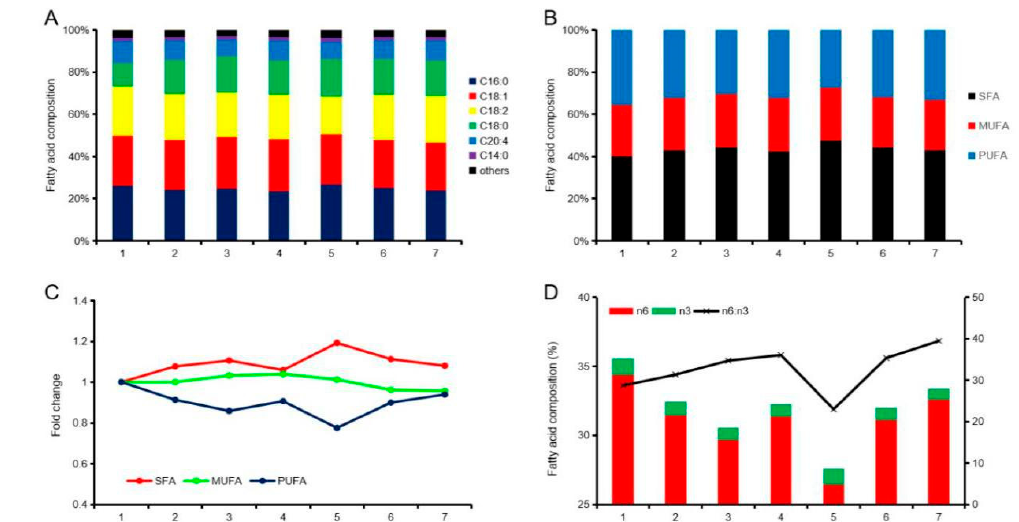
Figure 3. Analysis of fatty acid composition and characteristics in the longissimus dorsi muscle. ( A ) The content of the top 6 fatty acids. ( B ) A composition of saturated fatty acids (SFA), monounsaturated fatty acids (MUFA) and polyunsaturated fatty acids (PUFA) in longissimus dorsi muscle. ( C ) Changes in SFA, MUFA and PUFA contents. ( D ) The ratio of n6:n3 of longissimus dorsi muscle.